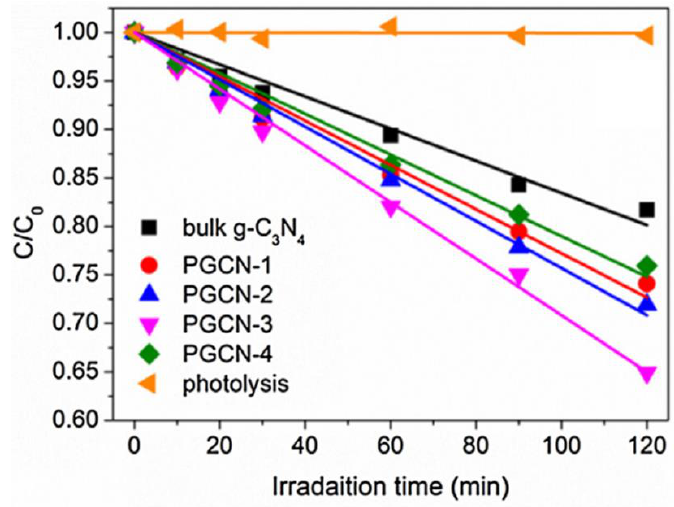
Figure 10. Photocatalytic degradation of PHBA upon irradiation in the absence or presence of different graphitic carbon nitride photocatalysts. Reproduced with permission from Ref. [62]. Copyright 2016 Elsevier.